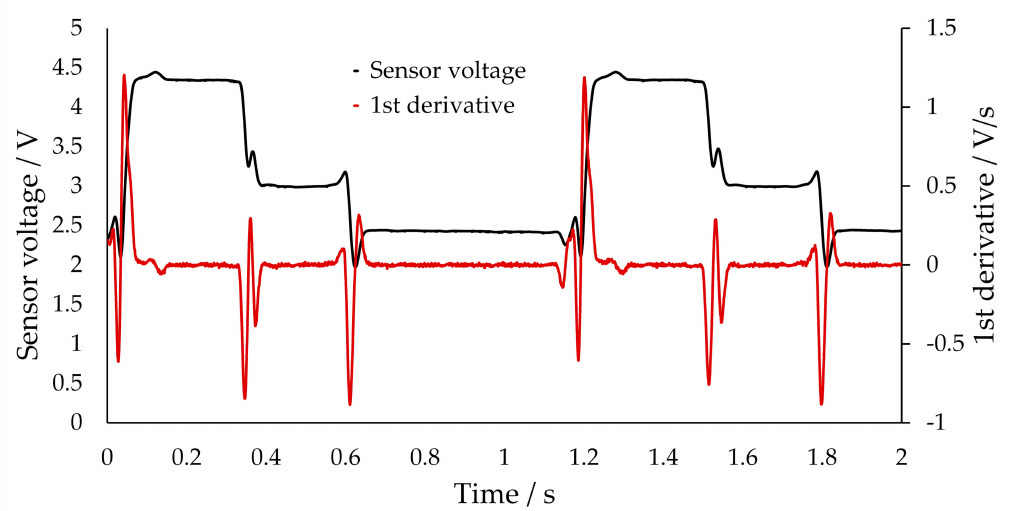
Figure 11. Transmissive sensor voltage (filtered with moving average) and its first derivative for a triphasic segmented slug flow at a position of 788 µ m (see Section 3.1). The plateaus can be assigned to the phases as follows: water, 1-hexanol, nitrogen in the direction shown from left to right; the nitrogen plateau is the